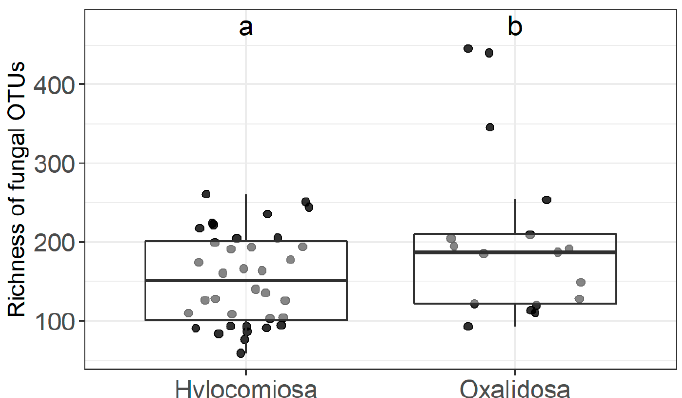
Figure 5. Effect of forest type on richness of fungal OTUs. Middle lines, boxes, whiskers, and circles represent medians, quartiles, 90% quantiles, and all sampled trees, respectively. Different letters above whiskers indicate statistically different groups ( p < 0.05). Number of stands: Hylocomiosa —36; Oxalidosa —17.